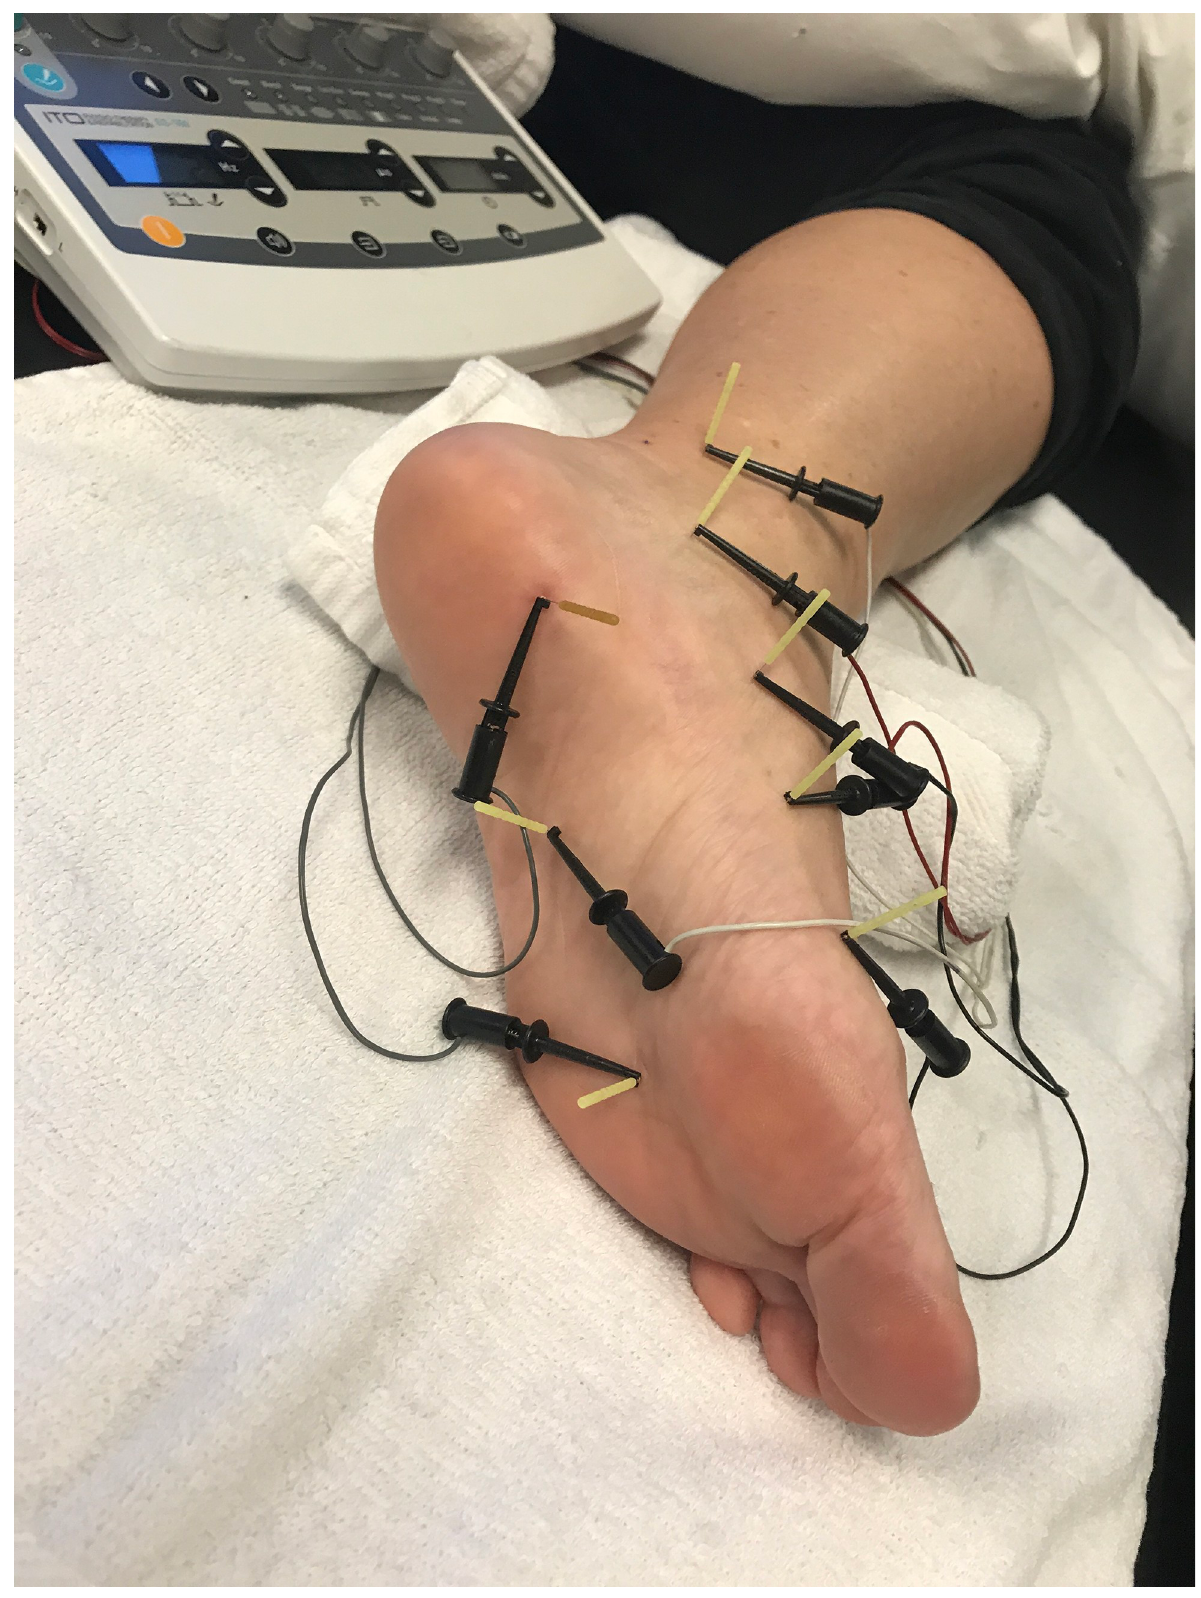
Fig 1. Standardized 8-point protocol of electrical dry needling for PF. https://doi.org/10.1371/journal.pone.0205405.g001 PLOS ONE | https://doi.org/10.1371/journal.pone.0205405 October 31,